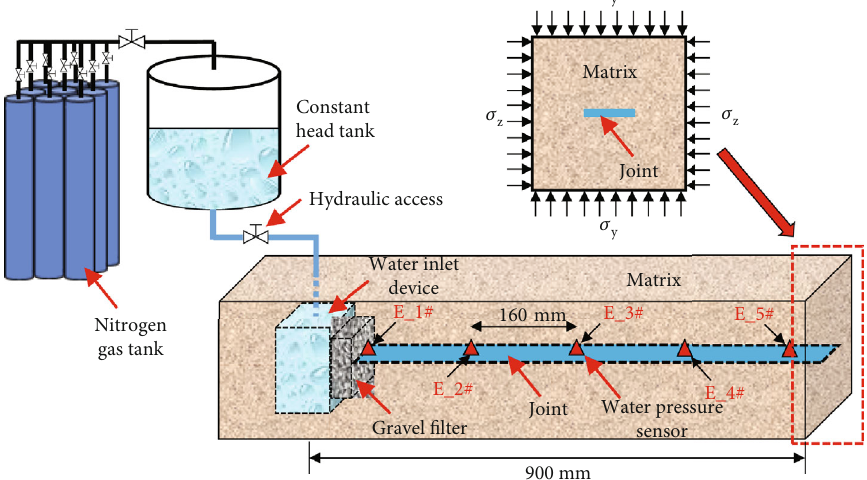
Figure 6: Schematic diagram of the water supply system and embedding location of the water pressure sensors.